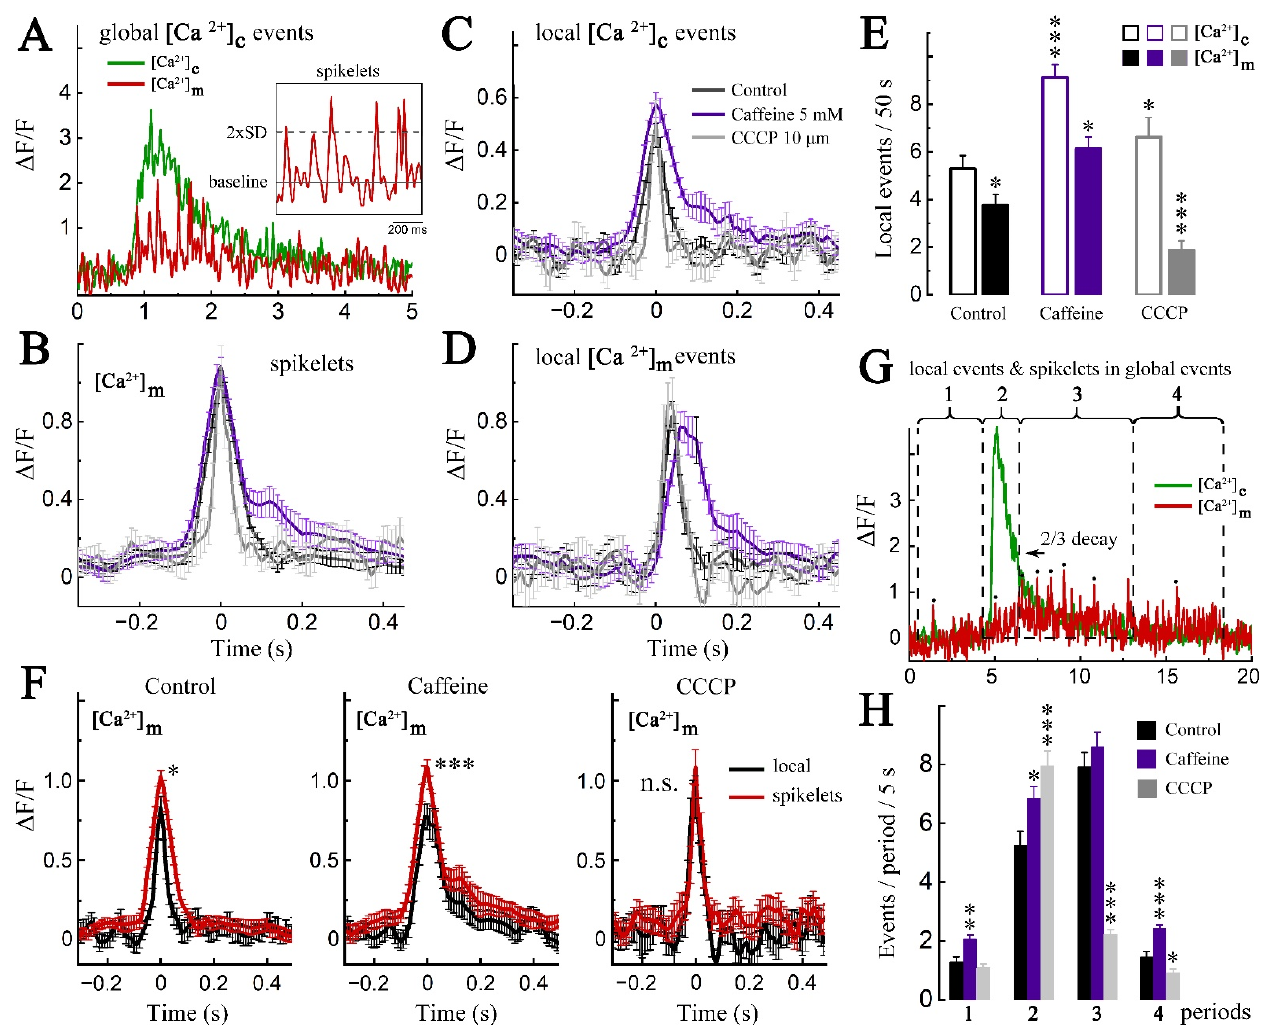
Figure 4. Comparison of mitochondrial calcium spikelets and local transients, recorded during global and local cytosolic events. ( A ) Example of global [Ca 2+ ]c event. The calcium elevation in mitochondria during the global event [Ca 2+ ]c contains separate isolated surges, «spikelets» of [Ca 2+ ]m. Insert shows enlaged fragment of the recording, shown below. Only spikelets, exceeding two standard deviation (SD) criteria, were taken into account. ( B ) Averaged [Ca 2+ ]m spikelets during global cytosolic elevations in control (black), caffeine (5 mM, violet) and CCCP (10 µM, gray). Multiple spikelets were collected from 4 clusters of 4 cells per each group and normalized by peak. An equal number of spikelets per cluster were averaged. ( C , D ) Averaged local [Ca 2+ ]c transient ( C ) and corresponding [Ca 2+ ]m transients ( D ), recorded from the same clusters and during the same pharmacological treatments. MT transients were synchronized with the peak in [Ca 2+ ]c; n of averaged transients from different clusters of four cells in each group: control = 32; caffeine = 27; CCCP = 12 transients. ( E ) Number of local calcium events (empty frames) and associated mitochondrial calcium transients (filled frames) in control, caffeine, and CCCP per 50 s; n = 4 clusters from different cells per each group. For [Ca 2+ ]c, F = 8.9924; control vs. caffeine ***, p < 0.001; control vs. CCCP, n.s.; caffeine vs. CCCP *, p < 0.05. For [Ca 2+ ]m, F = 22.16832, control vs. caffeine *, p < 0.05; control vs. CCCP *, p < 0.05; caffeine vs. CCCP ***, p < 0.001. One-Way ANOVA, post hoc Fisher’s test. ( F ) Amplitudes of averaged spikelets in global mitochondrial calcium elevations (red) and local mitochondrial calcium transients (black) in control, caffeine and CCCP. Data set is the same as ( B and D ). ( G ). Sample recording of cytosolic calcium (green) and mitochondrial calcium (red), divided into four time periods: 1—before the global calcium event, 2—from its beginning to 2/3decay of the peak, 3—to the complete cytocosolic calcium return to the baseline, 4—after the fully completed